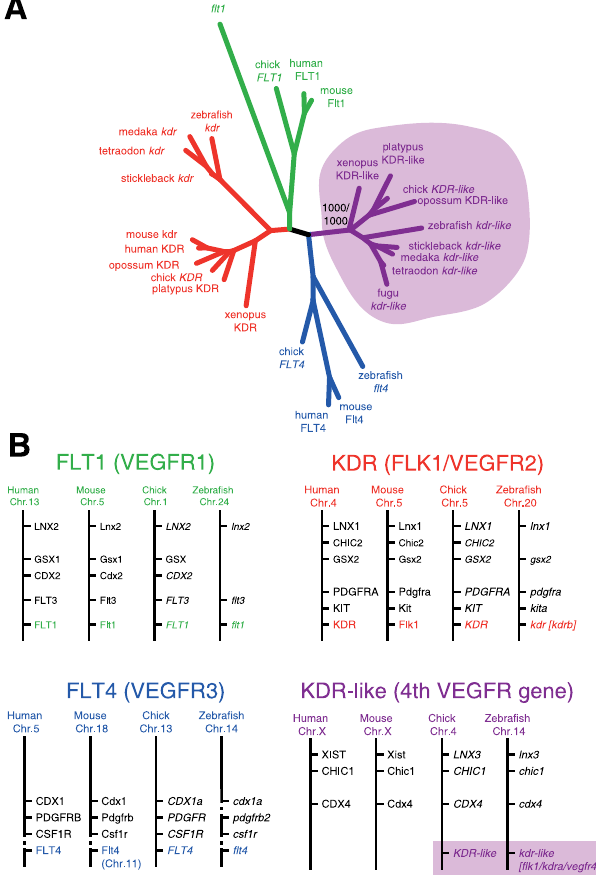
Figure 1. Adapted from Bussmann et al., 2007 [4]. A. Unrooted neighbor-joining tree of vertebrate VEGF receptors. Different colors represent different classes of VEGF receptors. Purple shading was used to highlight the fourth vertebrate VEGF receptor class, which is missing in eutherian mammals. The node representing this fourth class was supported in 1000/1000 bootstrap replicates. B. Synteny analysis of vertebrate VEGF receptors in the human, mouse, chick, and zebrafish genome assemblies. Different classes in A and B are colored similarly. Dashed lines represent synteny breaks in the Flt4 loci. Brackets indicate previously suggested names.